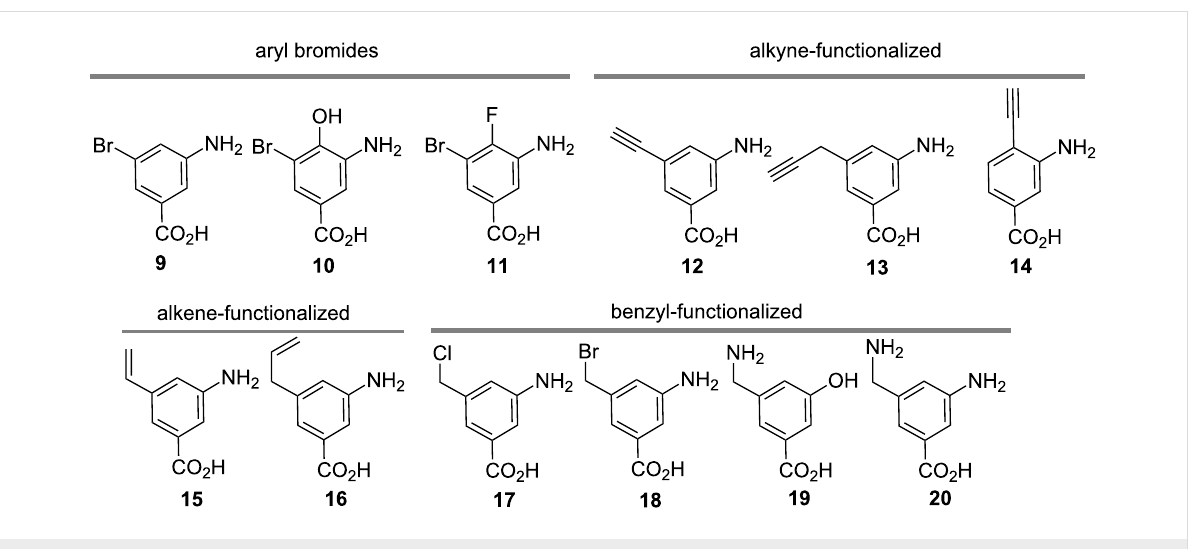
In contrast, benzoic acid 11 provided Br-F-ansamitocin deriva- tives 21a – d after being fed to a growing culture of the mutant strain as judged by HRMS (Scheme 4). The retention times in LC and MS experiments clearly showed common patterns for ansamitocins. Additionally, the isotopic pattern provided evi- dence for the incorporation of the bromo functionality (see Supporting Information File 1). However, yields for each of the four ansamitocins were too small for practical